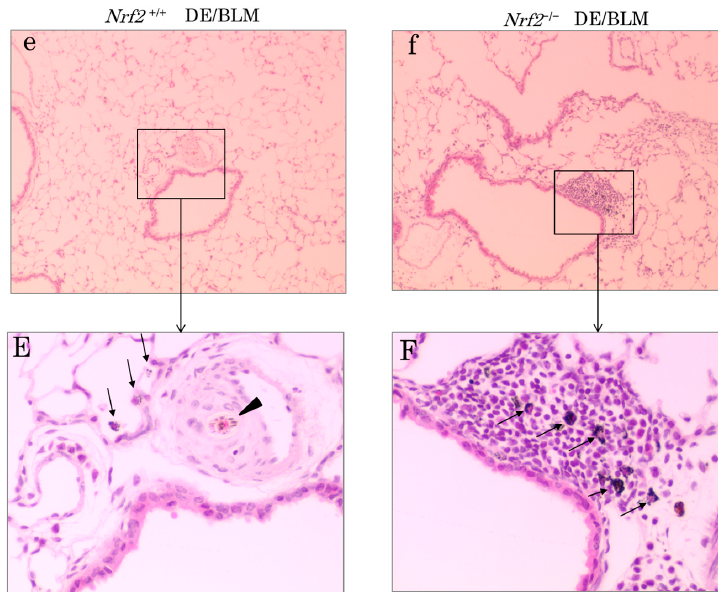
Figure 6. Histopathologic assessment on day 28 after BLM injection and after exposure to DE for a maximum of 56 days. These photographs show typical results. Clean air plus BLM-treated group in Nrf2 +/+ mice ( A , a ) and Nrf2 − / − mice ( B , b ); DE plus BLM-treated group in Nrf2 +/+ mice ( C , c ) and Nrf2 − / − mice ( D , d ). ( A – D ) original ×400; ( a – d ) original ×100, Masson Trichrome stain (MT) stain. The collagens fibers are blue colored in MT stain and triangle-headed arrows indicate fibroblastic foci. DE plus BLM-treated group in Nrf2 +/+ mice ( E , e ) and Nrf2 − / − mice ( F , f ). ( E , F ) original ×400; ( e , f ) original ×100, Hematoxylin Eosin (HE) stain. Arrows indicate DEP-laden alveolar macrophages surrounding the lesion. Arrowhead indicates the accumulated DEP-laden alveolar macrophages, which was considered a foreign-body giant cell ( E ).